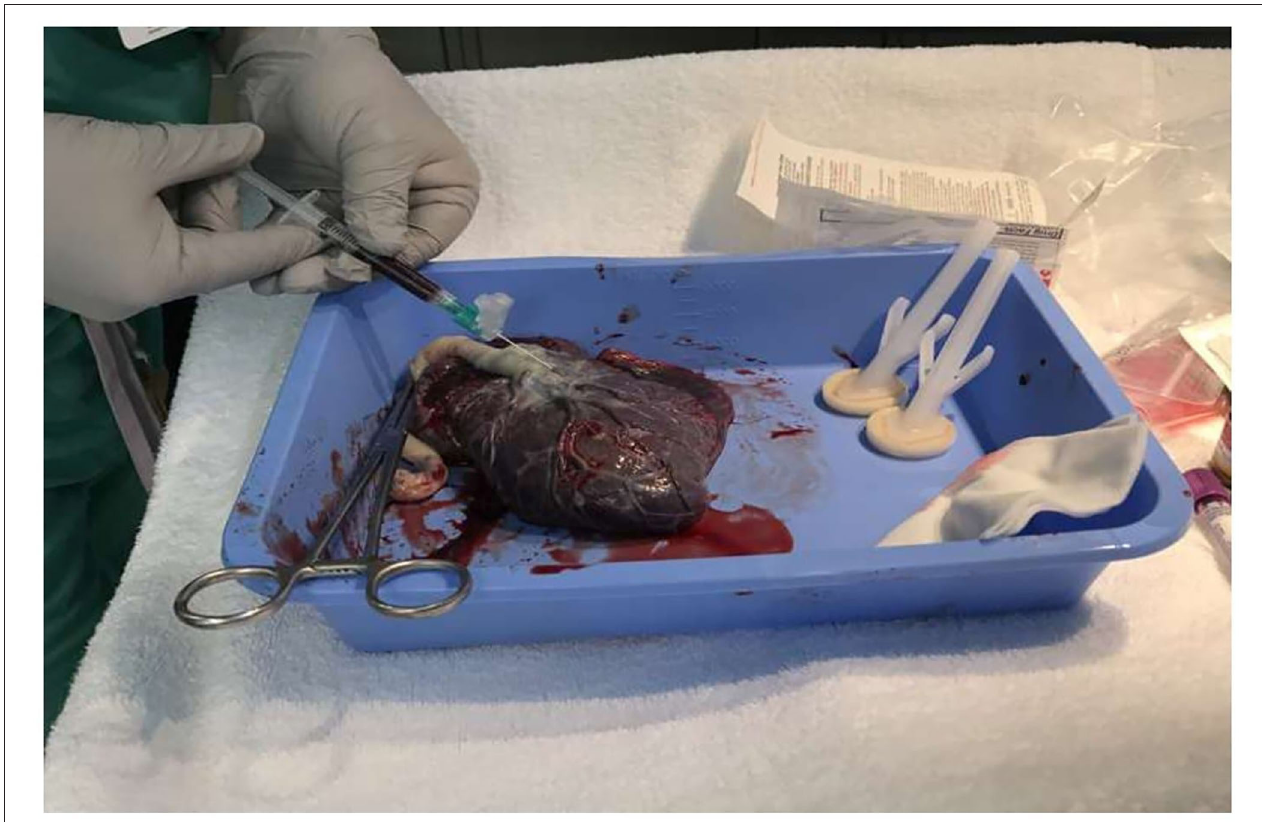
FIGURE 1 | Collecting blood sample from